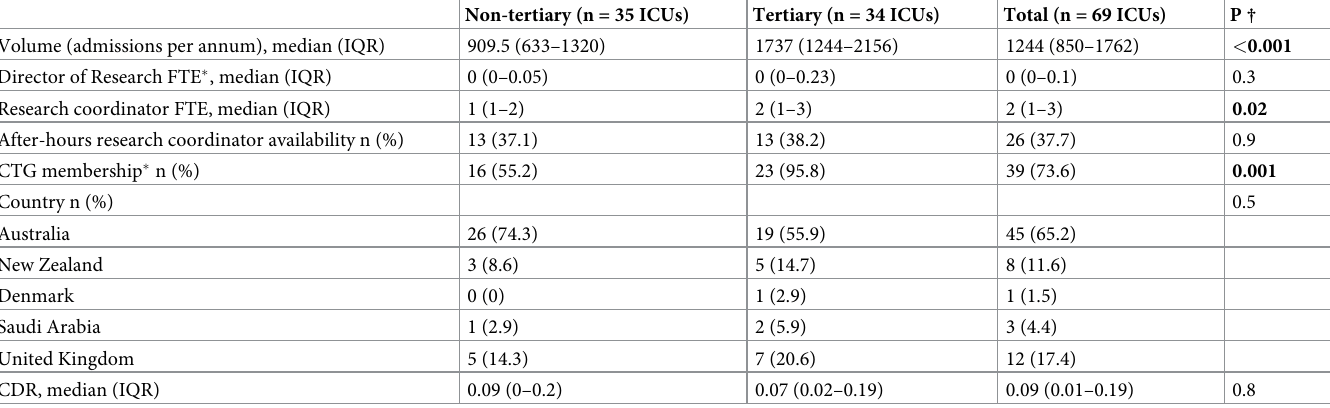
Table 1. Site-level characteristics of tertiary and non-tertiary ICUs that participated in the ADRENAL